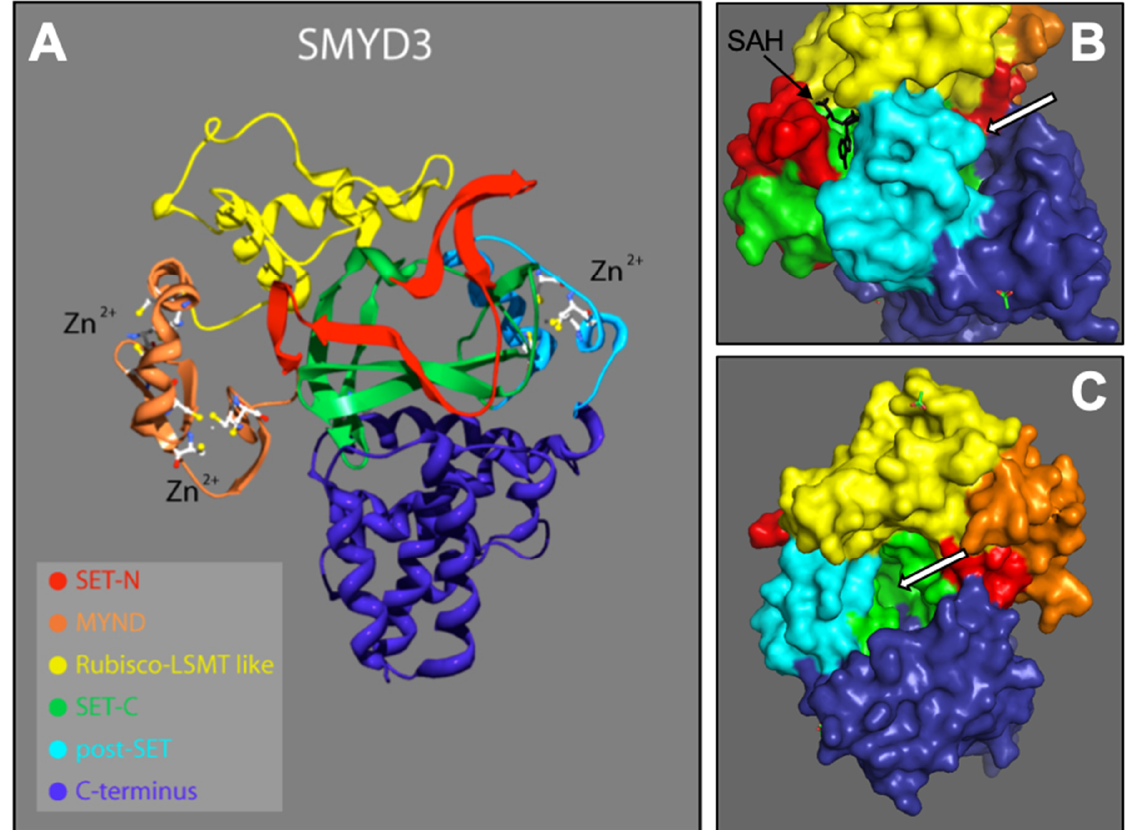
Figure 1. SMYD3 structure. 2.3 Å crystallized resolution. Colors represent regions of SMYD3 secondary structure: N-SET, C-SET, MYND, Rubisco-LSMT (I-SET), C-Terminus [16,17]. ( A ) Ribbon model, including Zinc atoms important for stability. ( B ) Surface model depicting SAH (methyl donor cofactor) in its native binding pocket. White arrros point to target protein bnding pocket. ( C ) Rotated surface model depicting target protein binding pocket.